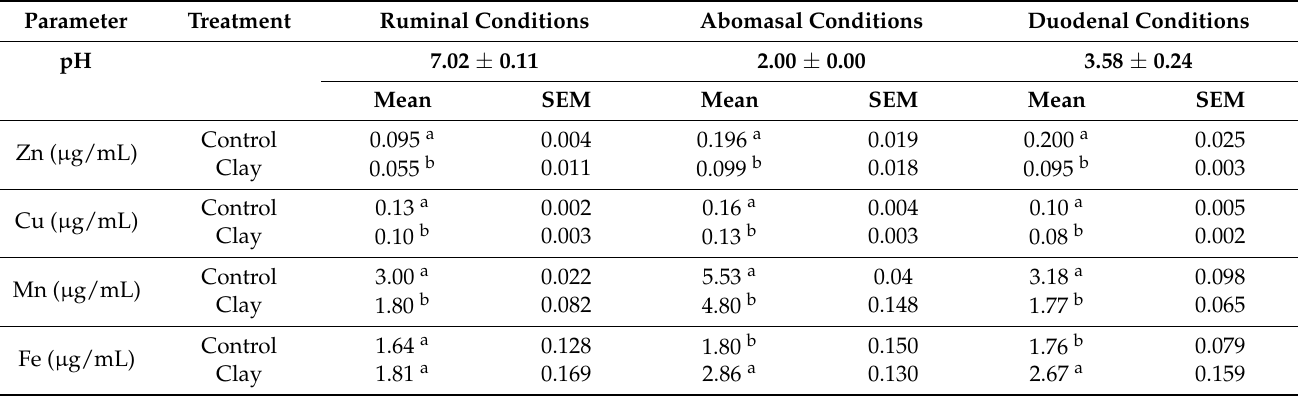
SEM = standard error of the mean. a,b Superscript letters indicate statistically significant differences between control and clay within each trace mineral and medium ( p < 0.05).